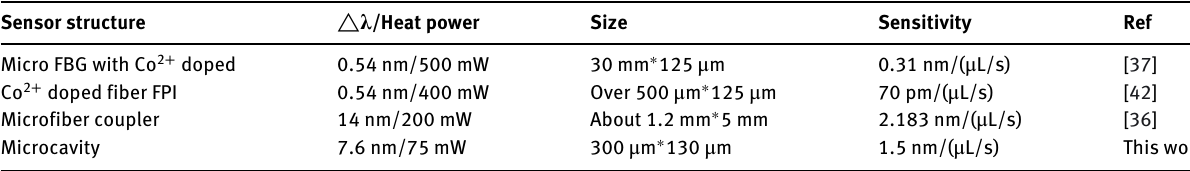
Table 1: Comparison of different hot wire liquid flow sensor technologies. Sensor